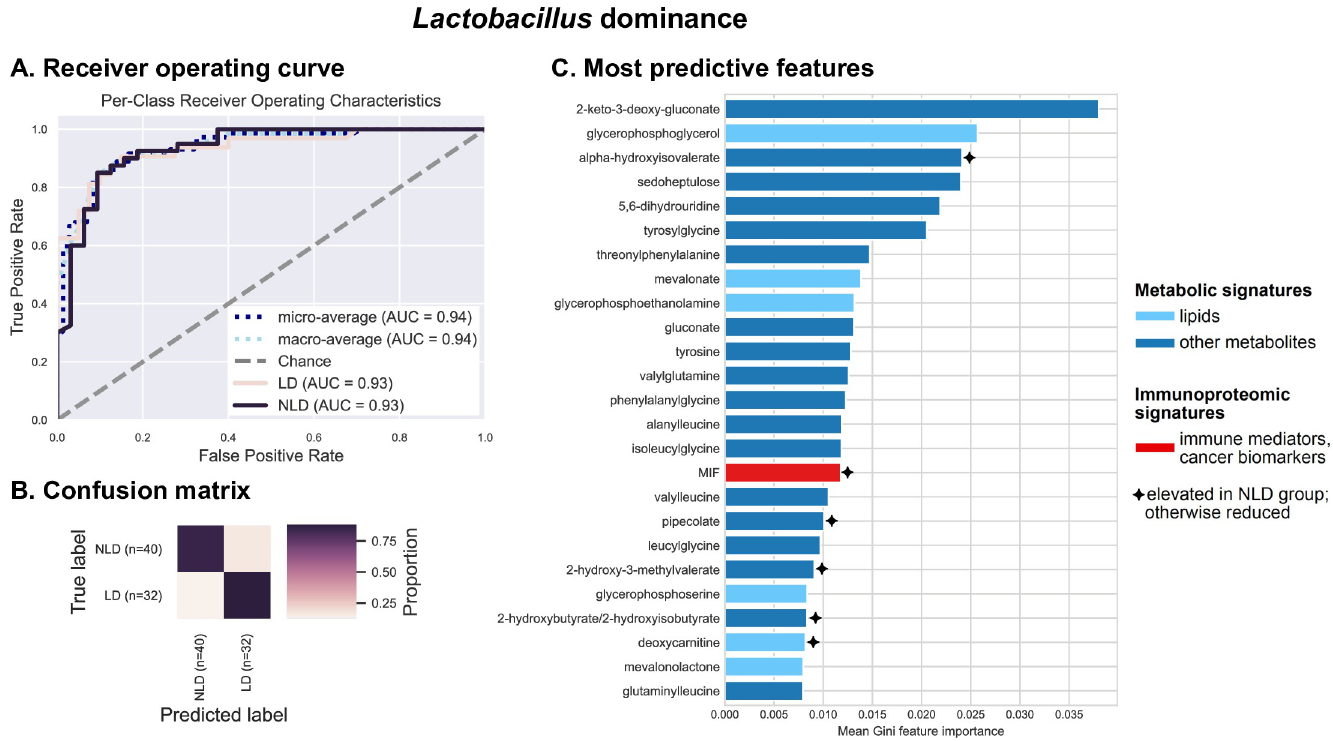
Fig 4. Metabolites (particularly xenobiotics, carbohydrates, amino acids and peptides) and the inflammatory cytokine MIF can accurately predict Lactobacillus dominance. Integrated vaginal metabolome and immunoproteome profiles were used as predictive features for training cross-validated Random Forest classifiers to predict whether a subject’s vaginal microbiota is Lactobacillus dominant (LD � 80% relative abundance consists of Lactobacillus ASVs) or non-LD (NLD < 80% relative abundance consists of lactobacilli). Combined measurements predict the Lactobacillus dominance at an overall accuracy rate of 86.1%. A 1.6-fold improvement over baseline accuracy was observed. Receiver operating characteristics (ROC) analysis showing true and false positive rates for each group, indicating excellent predictive accuracy for both LD (AUC = 0.93) and NLD groups (AUC = 0.93) ( A ). The confusion matrix illustrates the proportion of times each sample receives the correct classification when evaluating the classifier at a threshold of 0.5 ( B ). The graphs depict the 25 most strongly predictive features ranked by their mean Gini importance score across all 10 trained classifiers, a measure of their overall contribution to classifier accuracy ( C ).